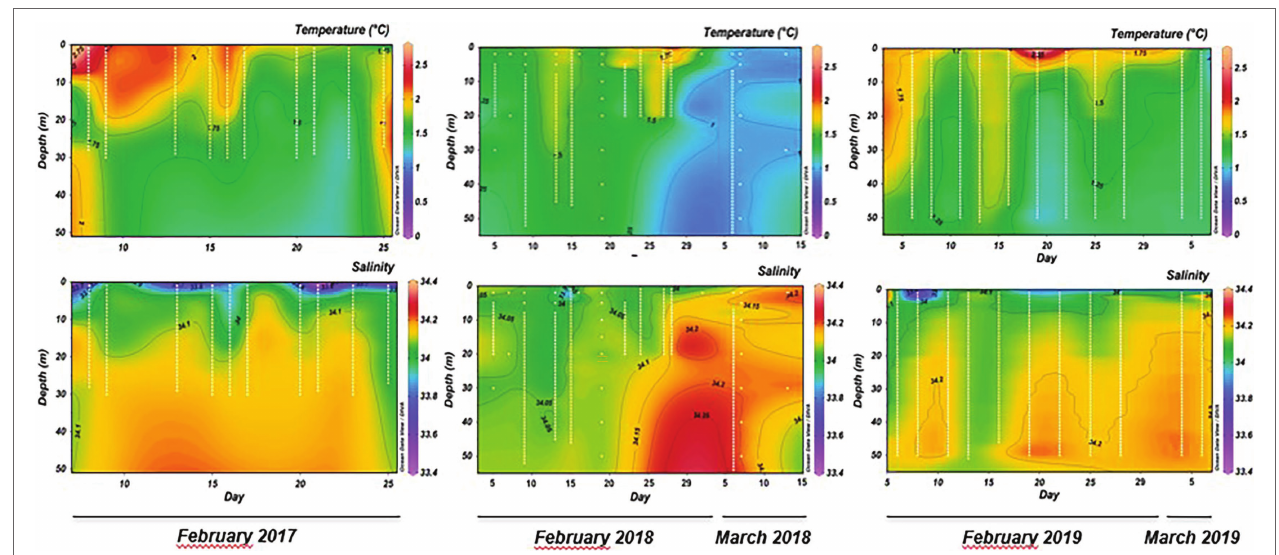
FIGURE 2 | Inter-seasonal physical variables (temperature and salinity) recorded at sampling station P3 in Chile Bay over three late-summer periods (February to early March 2017, 2018, and